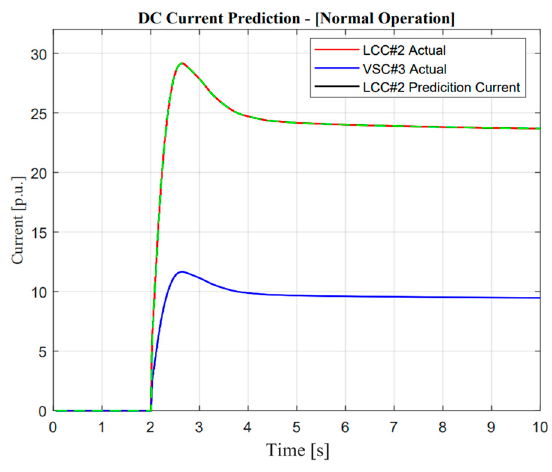
Figure 14. DC current prediction in normal operation.